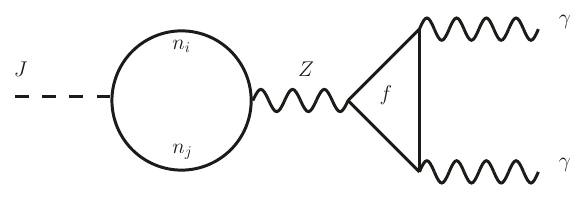
Figure 2 . One two-loop contribution to J ! (cid:13)(cid:13) via charged fermions f